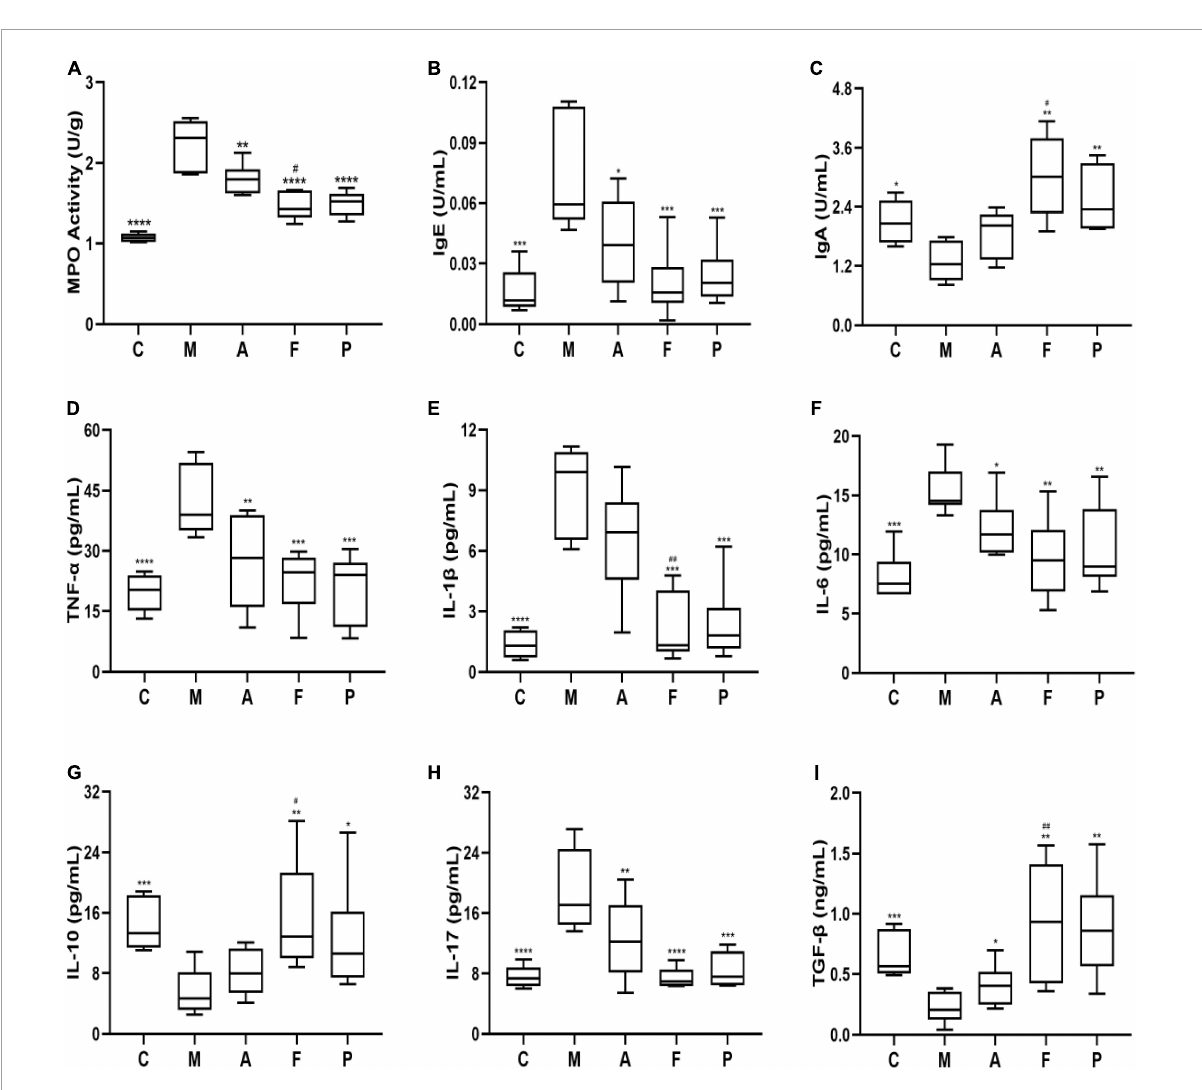
FIGURE2 FA attenuated the colonic inflammation and modulated the inflammatory cytokines balance in DSS-induced mice: (A) MPO; (B) IgE; (C) IgA; (D) TNF- α ; (E) IL-1 β ; (F) IL-6; (G) IL-10; (H) IL-17; (I) TGF- β in serum or colonic tissue. Data are mean ± SD ( n = 5–6). ∗ P ≤ 0.05, ∗∗ P ≤ 0.01, ∗∗∗ P ≤ 0.001, and ∗∗∗∗ P ≤ 0.0001 vs. the M group; # P ≤ 0.05 and ## P ≤ 0.01 vs. the A group.